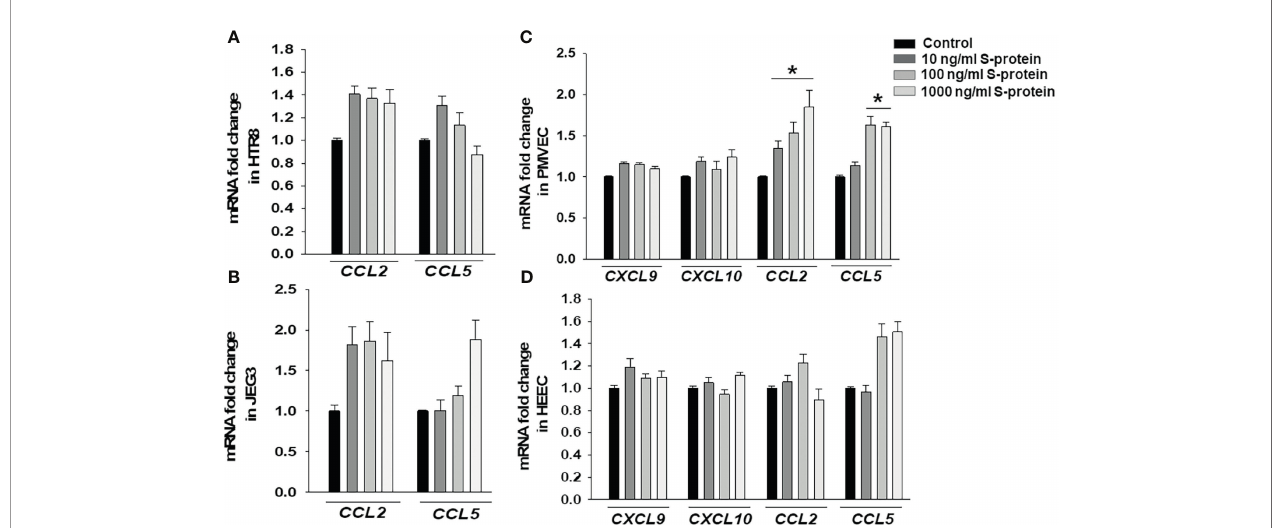
FIGURE 3 | Expression chemokines mRNA in trophoblastic and endothelial cells cultures treated by rh-S-protein. qPCR analysis revealed to measure of expression levels of CCL2, CCL5, CXCL9 and CXCL10 in HTR8/SV Neo (A) , JEG3 (B) , PMVEC (C) and HEEC (D) cultures treated with 10, 100, or 1000 ng/ml rh-S-protein vs. control. Bars represent mean ± SEM, n=4; * P<0.05 vs.